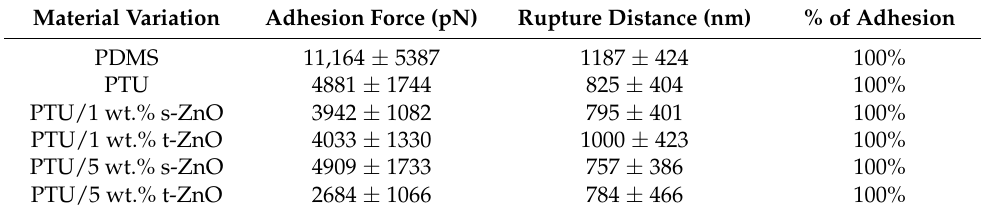
Table 6. The mean value of the adhesion force and the rupture distance of C. glabrata on a variation of six different material surfaces. The right column presents the percentage of curves presenting adhesive